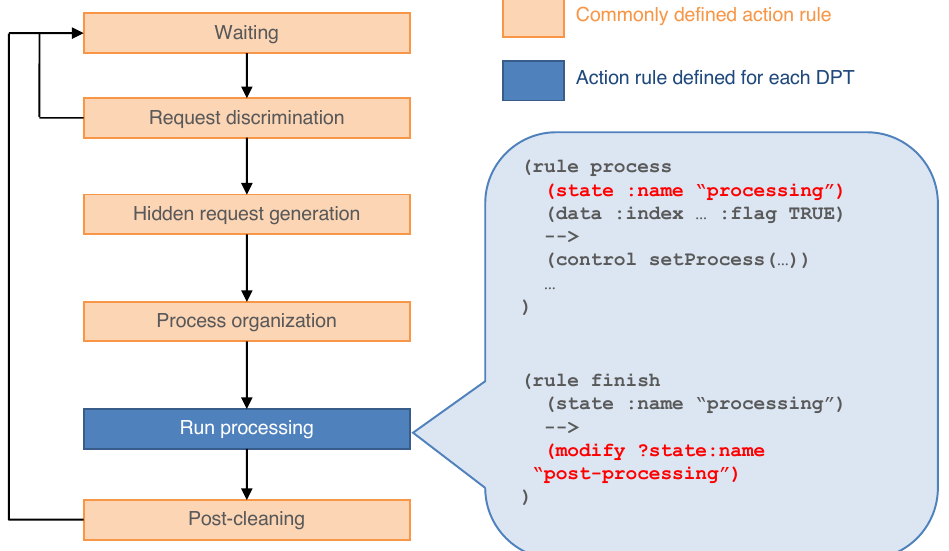
Figure 7. Action flow diagram for the DPA. We developed the common parts (templates) of the steps in orange. When encapsulating another DPT, the blue part must be implemented.